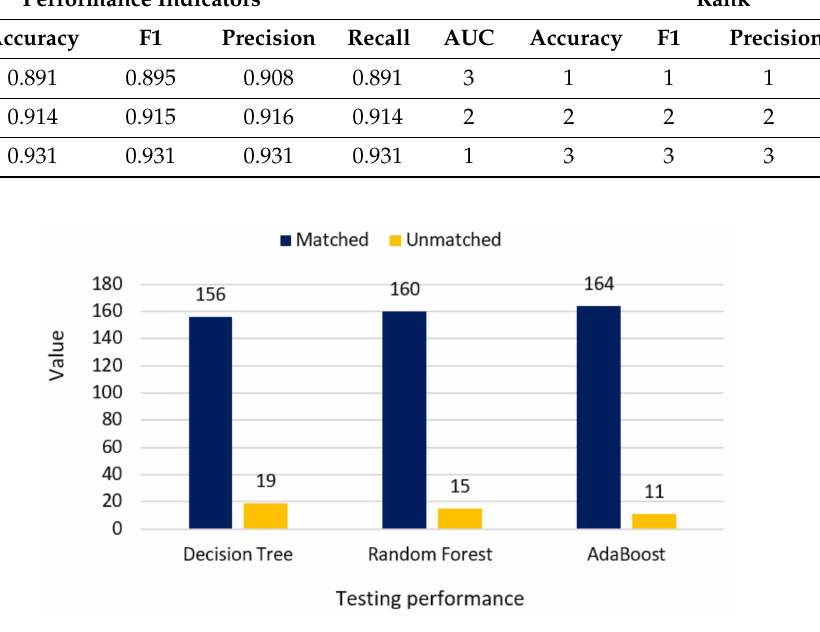
Figure 10. Chart of results obtained from the models compared to expected